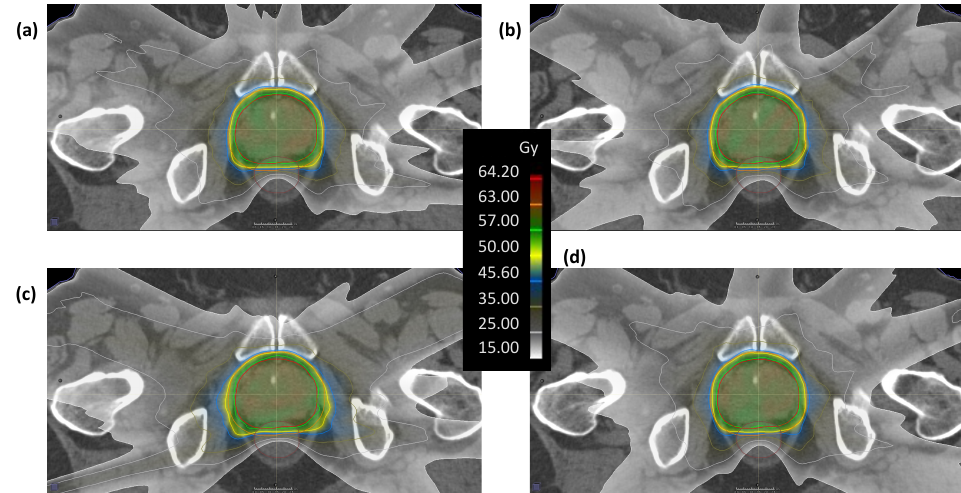
Figure 5. Transverse CT slice of the first validation patient (patient 21) showing dose distributions for each calibration method. Delineated volumes are rectum (brown), PTV60 (red) and PTV48 (orange). Tiles are: ( a ) MCO gs , ( b ) PGAP std , ( c ) PGAP-ML reg and ( d ) PGAP-ML clus